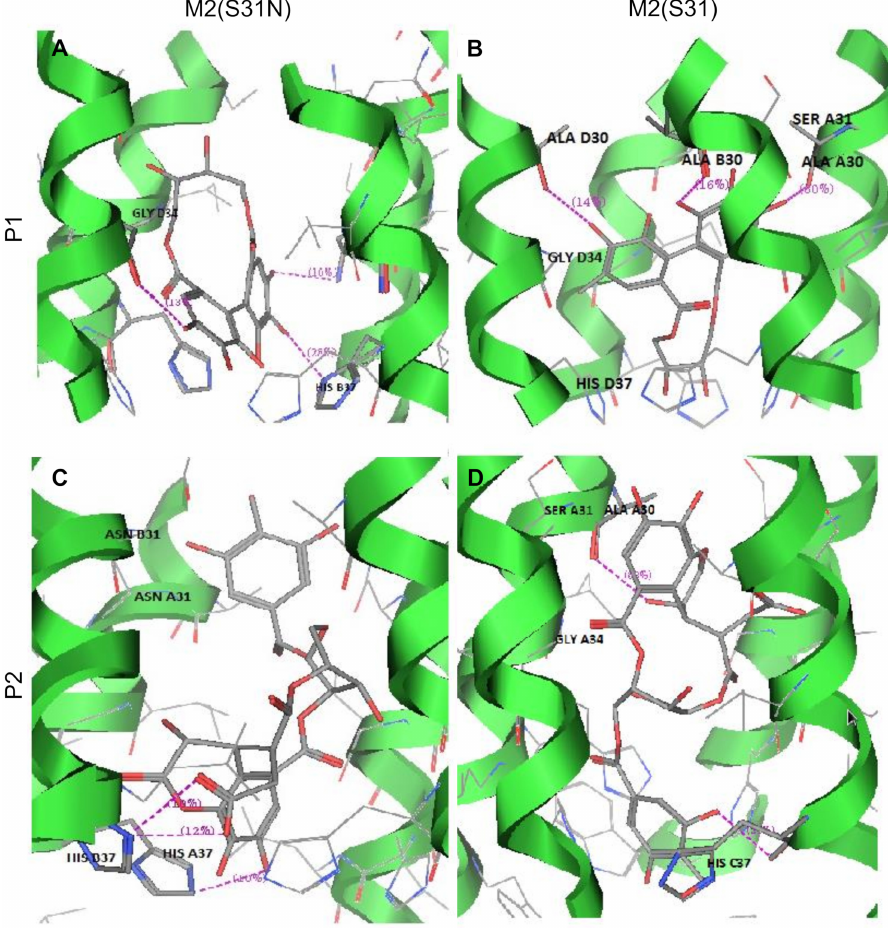
Figure 6. 3D pictures of protein-ligand interactions between P1 and P2 into M2(S31N) and M2(S31). For each panel, the proposed ligand-protein interactions, amino acids and M2 subunit ( A − D ) are labelled, with H-bonds shown as pink broken lines. Table 2. E ff ects of amantadine, M2WJ352, and chebulagic acid on viral replication, as measured by 50 * TCID 50 -based cytopathic assay. Results indicate mean ± SD of at least 3 independent experiments with at least 4 replicates per